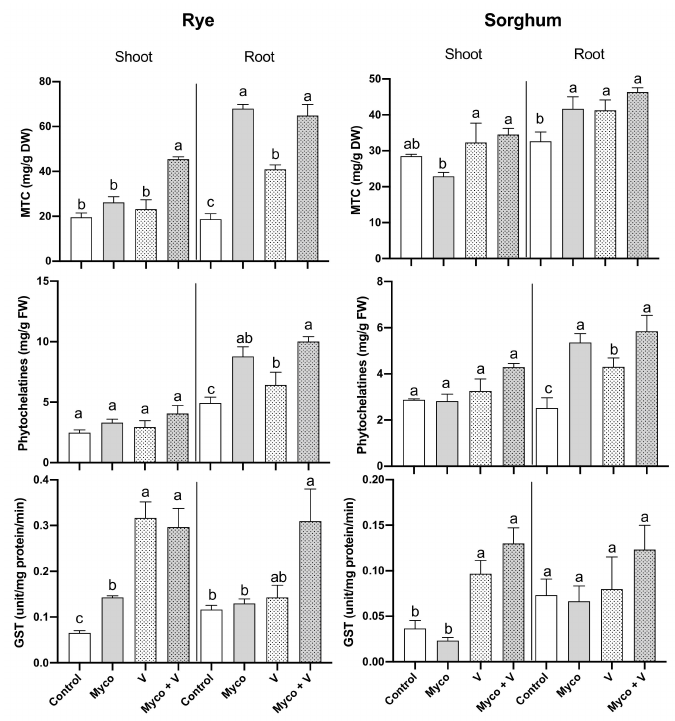
Figure 4. Changes in MTC and phytochelatins content and GST activity in shoots and roots of six-week-old rye and sorghum grown in soils with 0 or 350 mg/kg soil sodium vanadate and with or without soil enrichment with inoculum of the mycorrhiza Rhizophagus irregularis . Data are mean values ± SE ( n = 3). Data were statistically analyzed by one-way ANOVA followed by Tukey’s posthoc test for comparing the means. Different letters indicate statistically significant difference between means of the same plant species at significance level of at least ( p ≤